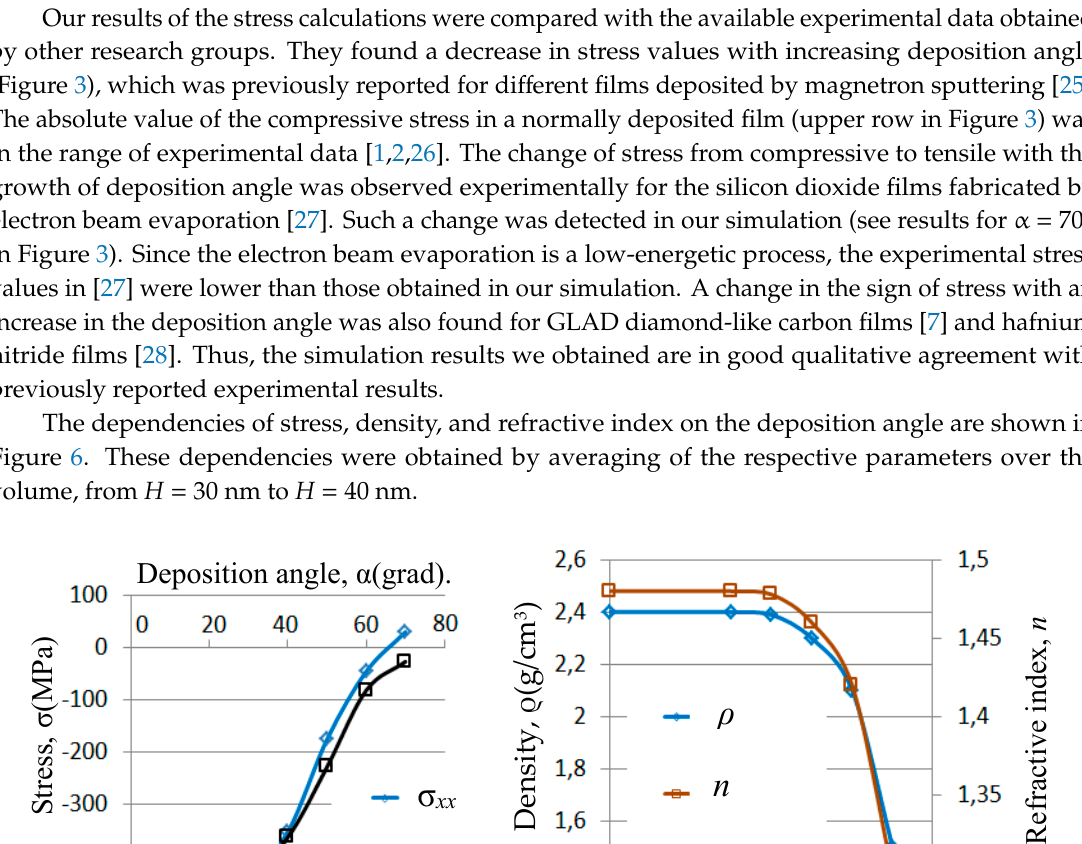
Figure 5. Distribution of the stress tensor components over the vertical coordinate h , α is the deposition angle.